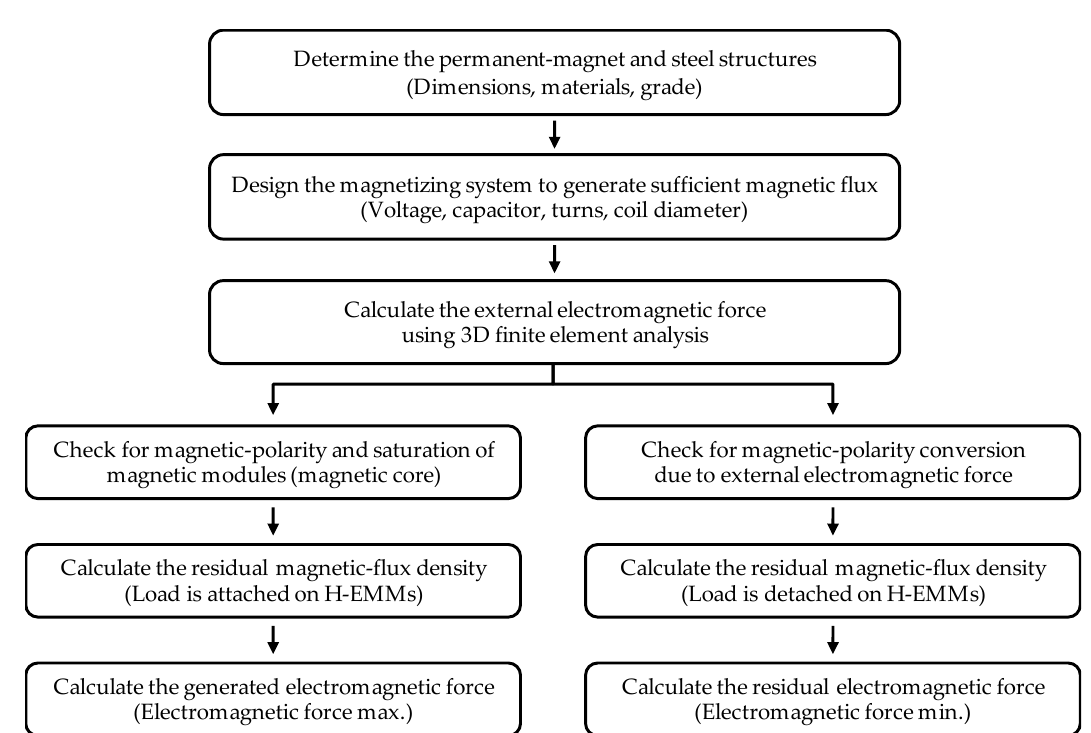
Figure 4. Design process for electromagnetic structure of H-EMMs.